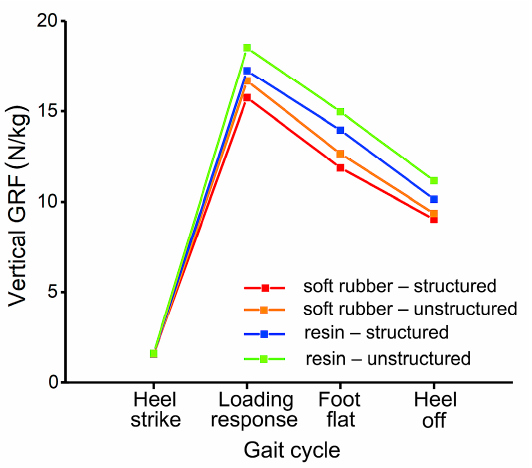
Figure 7. Vertical GRF of the four bionic heel pads at four key time instants during normal walking in FE simulations.